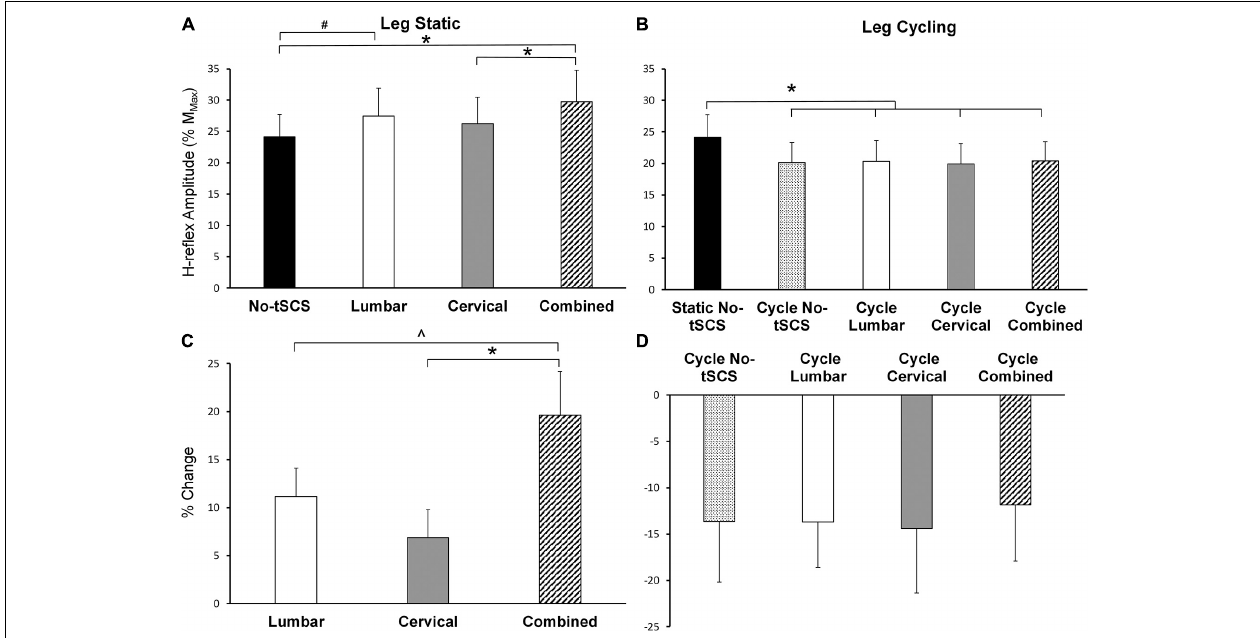
FIGURE 7 | Effect of tSCS on FCR H-reflex amplitude while the legs were static or cycling. (A) Average H-reflex peak-to-peak amplitude during the application of tSCS while the legs were held static. Combined tSCS increased the amplitude of the H-reflex significantly more than No-tSCS and Cervical tSCS. Lumbar tSCS significantly increased the amplitude of the H-reflex compared to No-tSCS. (B) Average peak-to-peak H-reflex amplitude during the application of tSCS while the legs were cycling. There was a significant reduction in H-reflex amplitude for all cycling conditions regardless of tSCS site compared to the legs static, No-tSCS condition. (C) Percent increase in H-reflex amplitude during Lumbar, Cervical, and Combined tSCS while the legs were static relative to No-tSCS. The% increase in H-reflex amplitude with Combined tSCS was significantly larger than that with Lumbar or Cervical tSCS. (D) Percent decline in H-reflex amplitude during all tSCS conditions while the legs were cycling relative to the legs static, No-tSCS condition. * p < 0.05, # p = 0.059, ˆ p = 0.053. Values are Mean ±